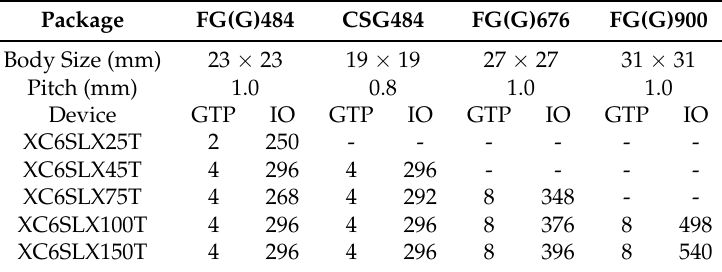
Table 2. Spartan-6 Family Overview with GTPs.